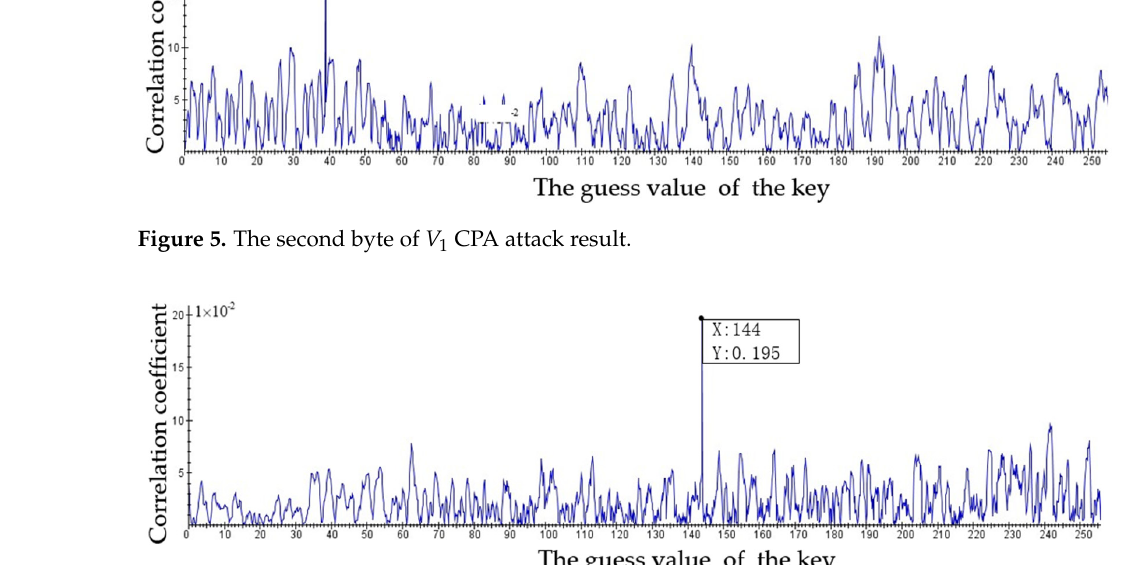
1 CPA attack result.